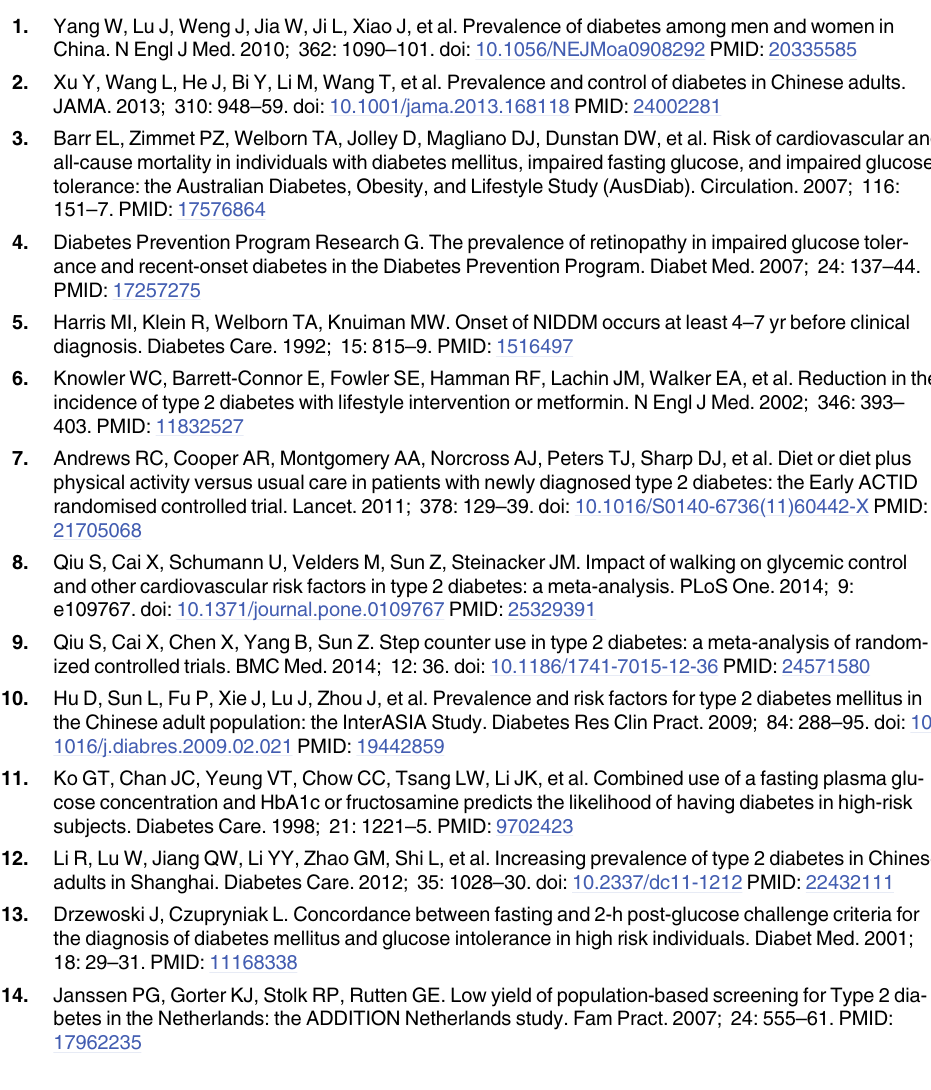
S1 Table. Parameters related to the optimal critical line from the model on the fasting plasma glucose plus serum advanced glycation end